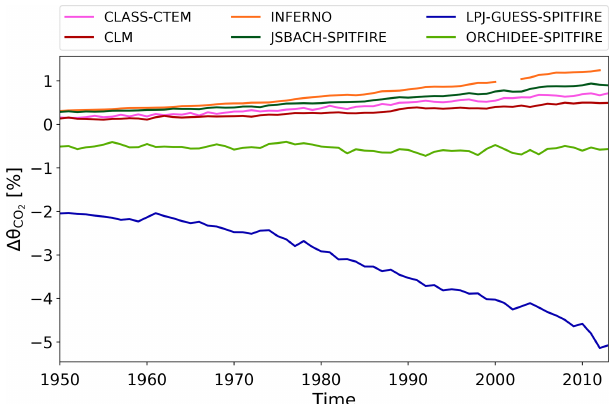
Figure 6. Annual average of the relative difference in volumet- ric soil moisture (CLM) and total soil moisture content (remaining models) between the baseline experiment SF1 and the sensitivity experiment SF2_CO2 (see Table 1; (cid:49)θ CO ) for 1950–2013 in per- 2 cent. Due to a postprocessing error, INFERNO lacks 2 years (2001 and